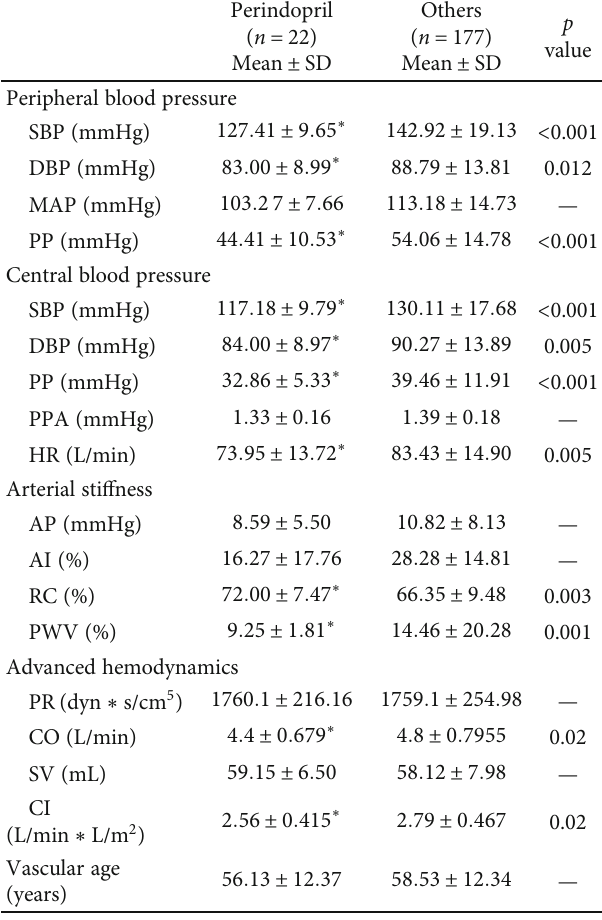
Table 8: Peripheral and central blood pressure indices in a subgroup of patients treated with perindopril vs.